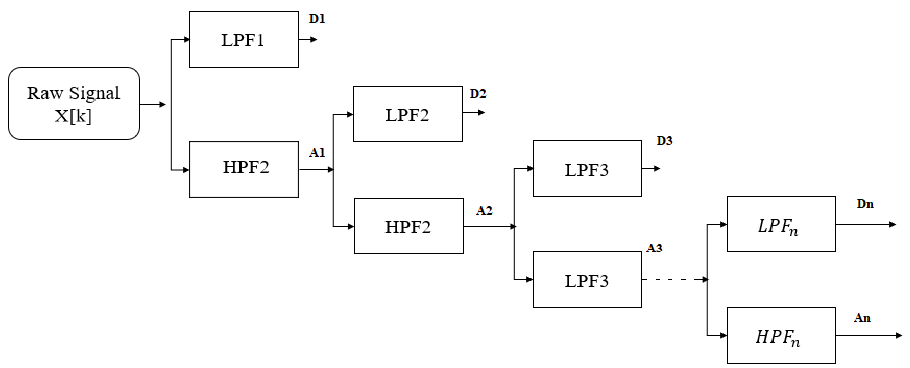
Figure 7. Discrete wavelet decomposition process.